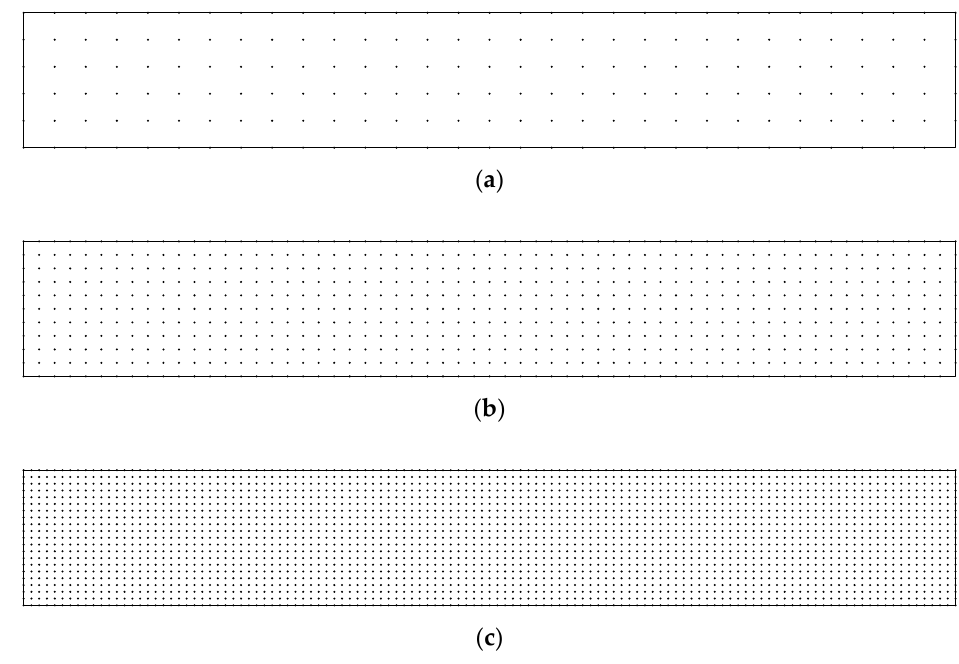
Figure 19. Nodal arrangements of the PDM models for the error analysis: ( a ) 186-node model (31 × 6), ( b ) 671-node model (61 × 11), and ( c ) 2541-node model (121 × 21).